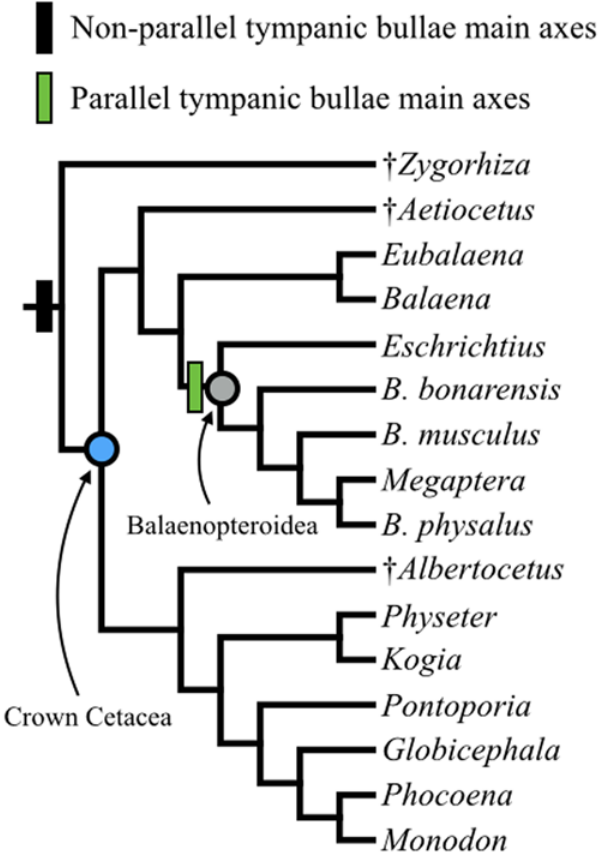
Fig 3. Phylogeny of extant and fossil cetaceans examined in this study. Zygorhiza , select extinct crown cetaceans, and odontocetes have tympanic bullae whose main axes converge anteriorly. In contrast, the clade Balaenopteroidea possess tympanic bullae whose main axes are parallel to each other and the skull, correlating with a recently described lateral sound reception pathway, evident at least in balaenopterids. Phylogeny based on